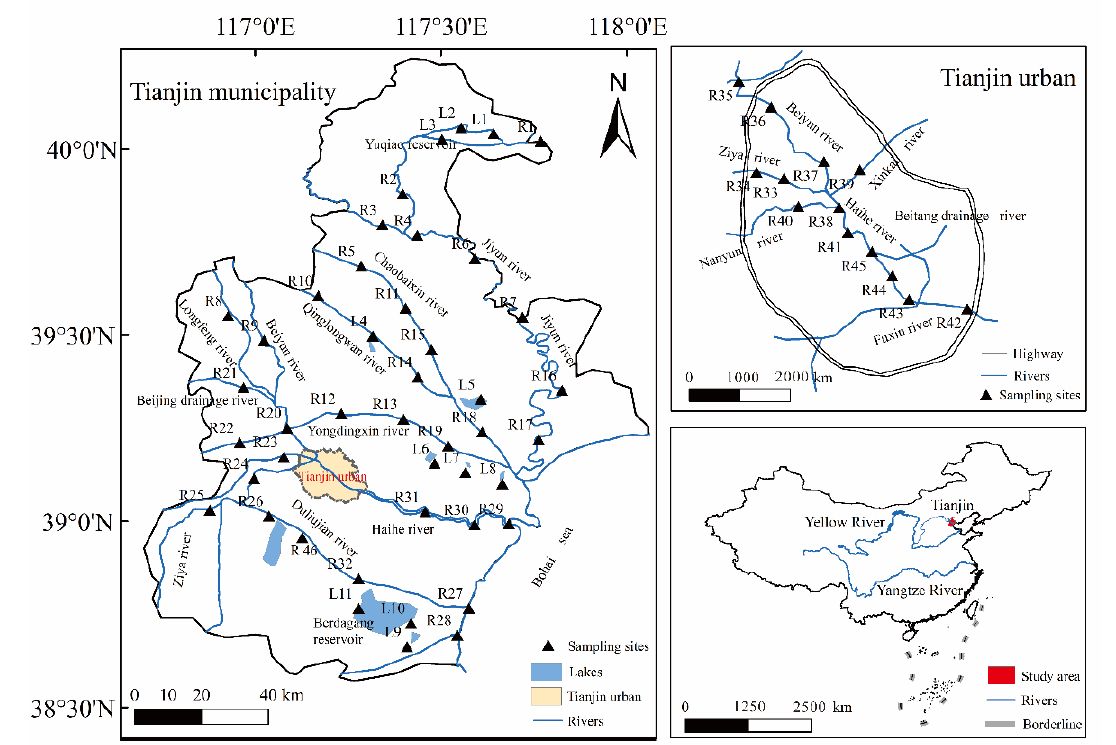
Figure 1. Map of sampling sites in Tianjin river network.